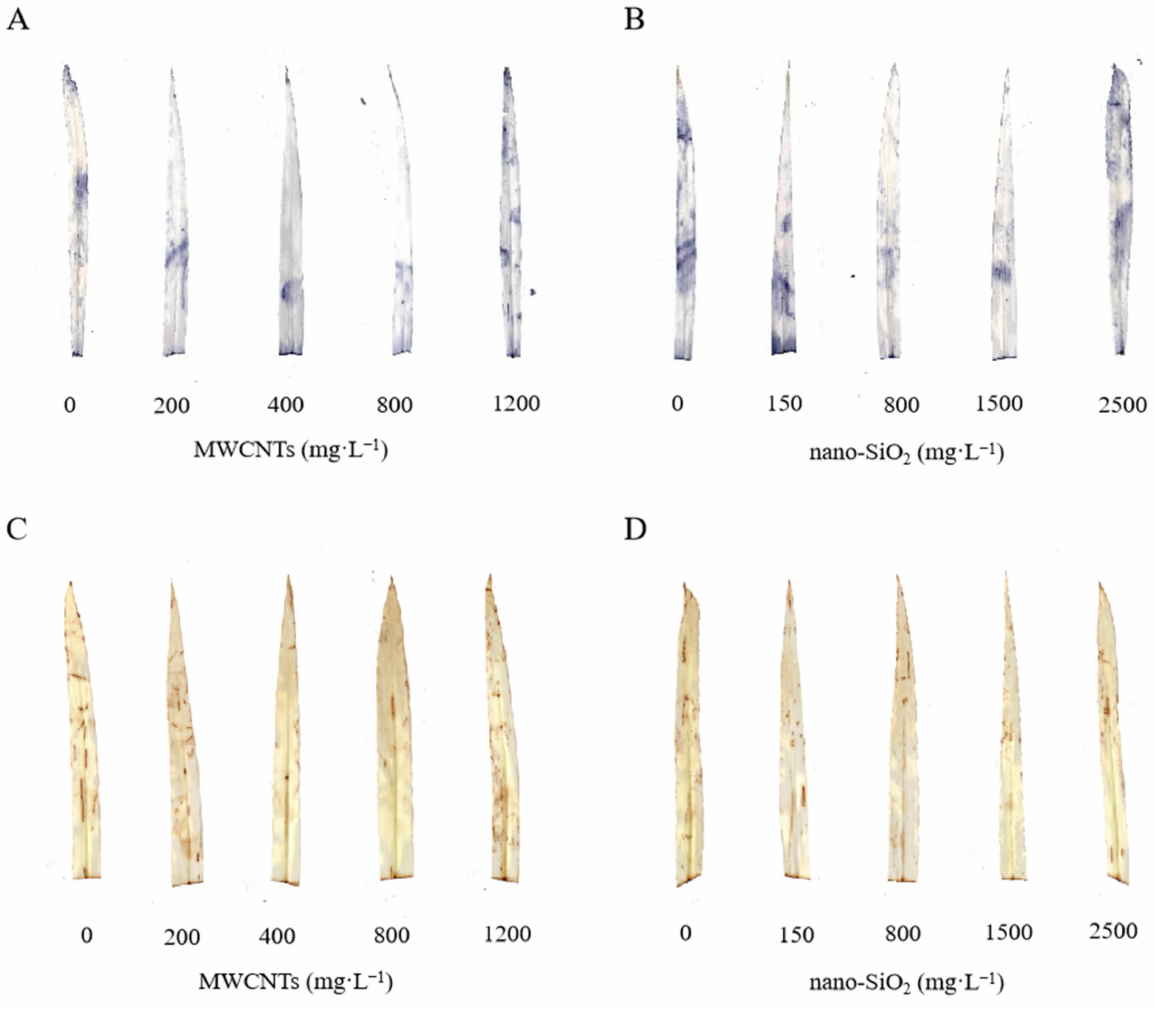
Figure 5. Effect of different concentrations of MWCNTs and nano-SiO 2 on detection of superoxide anion (O 2 ·− ) ( A , B ) and hydrogen peroxide (H2O2) ( C , D ) in vivo in maize